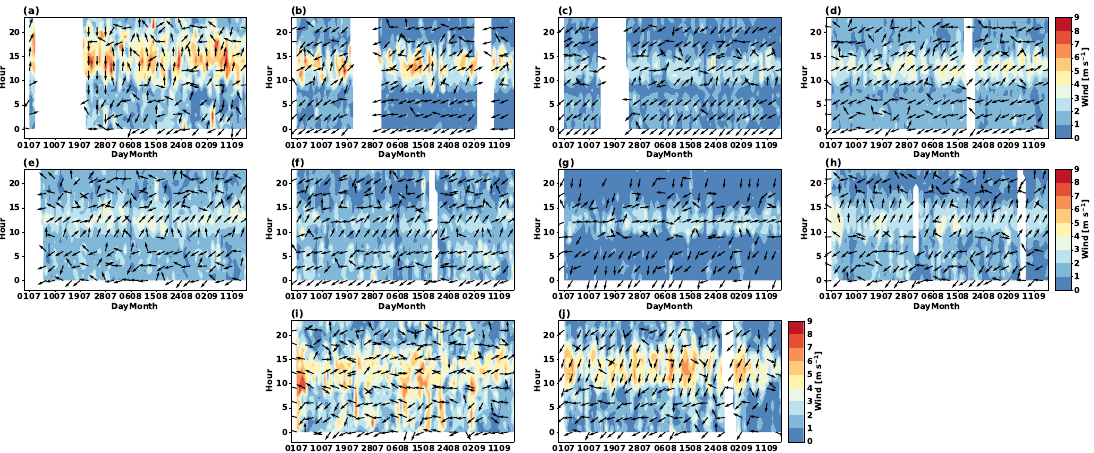
Figure 3. Hourly distribution of the surface wind (m s − 1 ) during the period 1 July 2004–16 September 2004 for ( a ) Puntarenas, ( b ) Guacalillo, ( c ) Capulín, ( d ) Lagunilla, ( e ) Orotina, ( f ) Hacienda Vieja, ( g ) Escuela de Ganadería, ( h ) La Garita, ( i ) JSIA, and ( j )